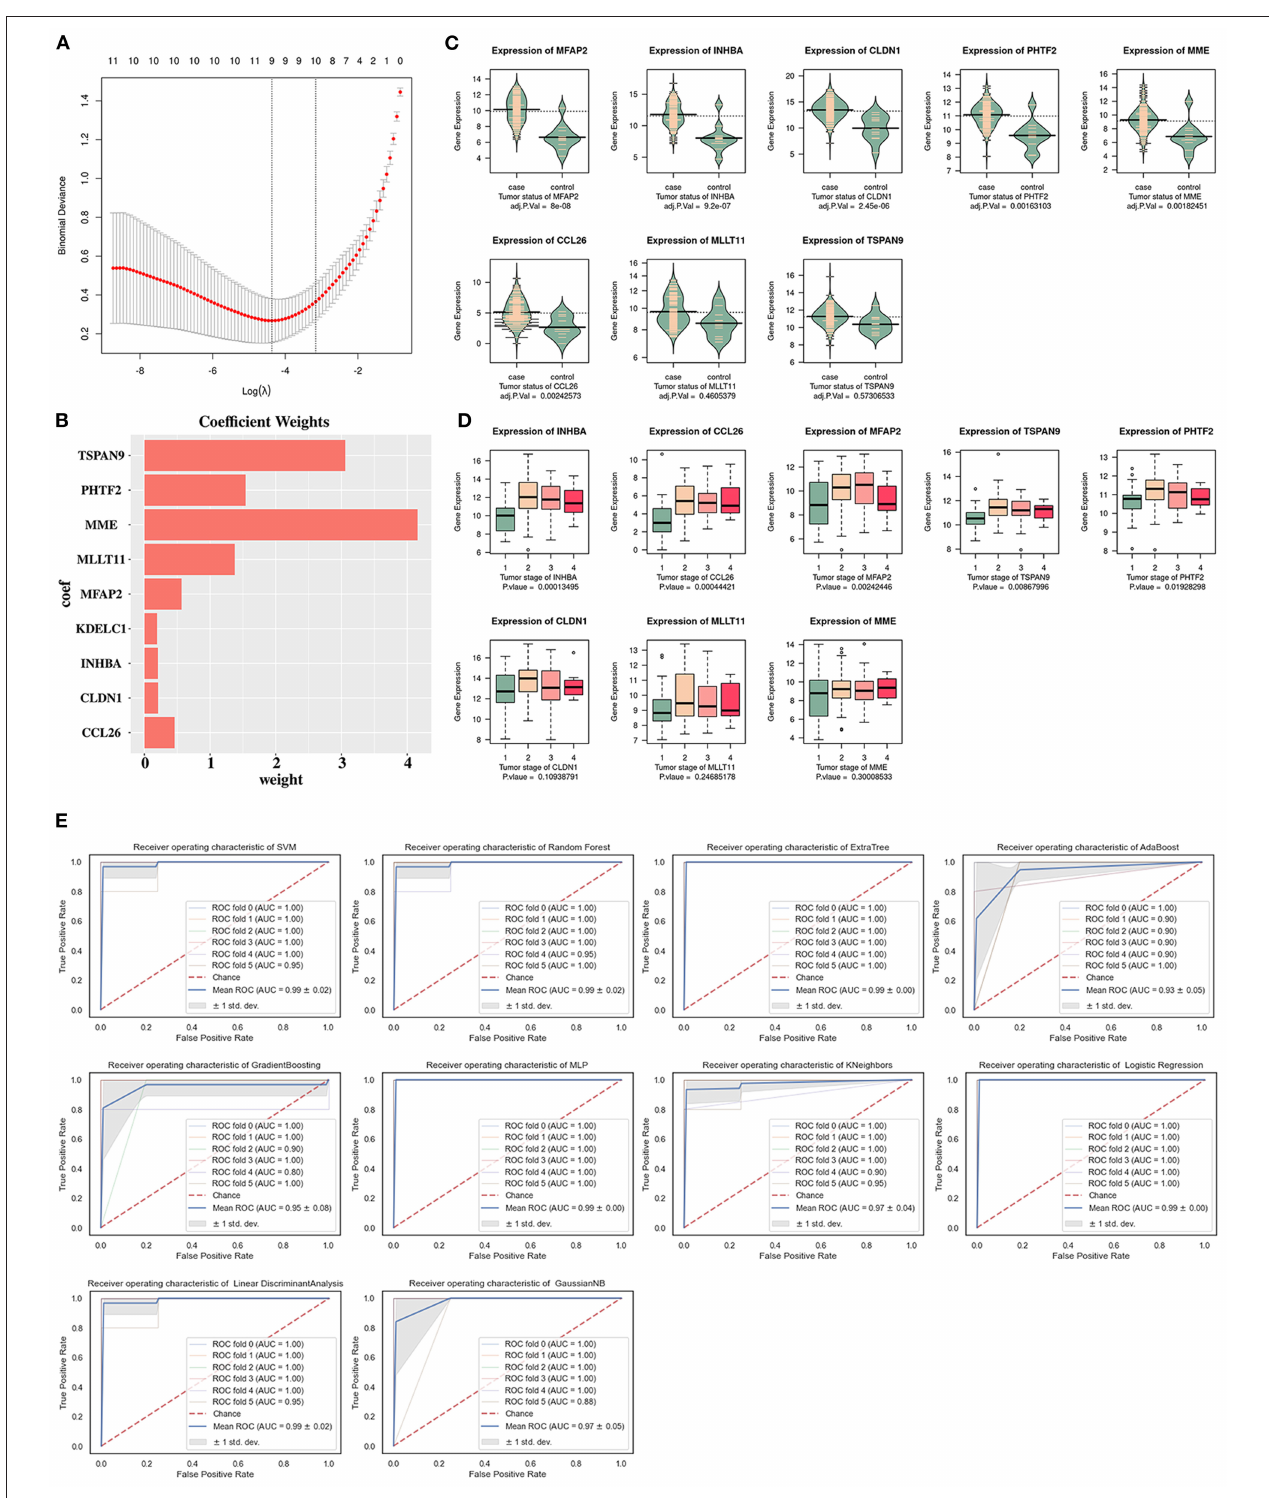
FIGURE 5 | Identification of the paclitaxel resistance-specific key genes by least absolute shrinkage and selection operator (LASSO) analysis based on GSE161533. (A) Cross-validation of LASSO analysis of the paclitaxel resistance-specific key genes. (B) Coefficient weights of the paclitaxel resistance-specific key genes. (C) Expression levels of the paclitaxel resistance-specific key genes in the tumor group compared with the normal group based on The Cancer Genome Atlas Esophageal Carcinoma (TCGA-ESCA). (D) Expression levels of the paclitaxel resistance-specific key genes in four tumor stages based on TCGA-ESCA. (E) Area under the ROC curve (AUC) values of 10 esophageal squamous cell carcinoma (ESCC) classifiers of the paclitaxel resistance-specific key genes based on GSE161533.